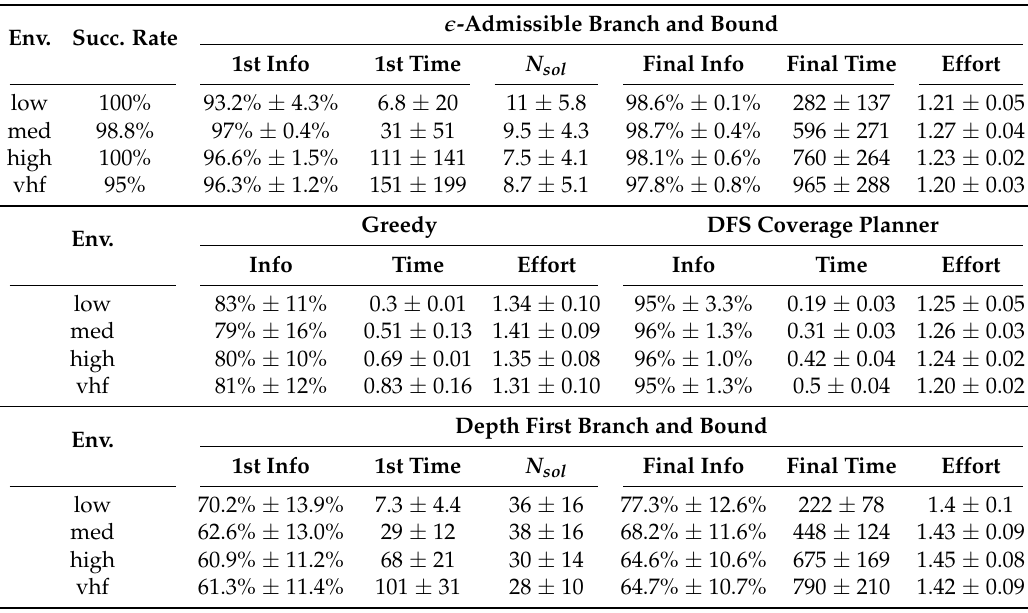
Table 3. Experiment results for nonuniform environments, mean of 80